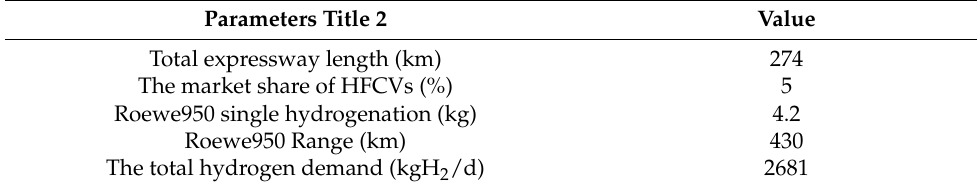
Table 2. Summary of key parameters of hydrogen